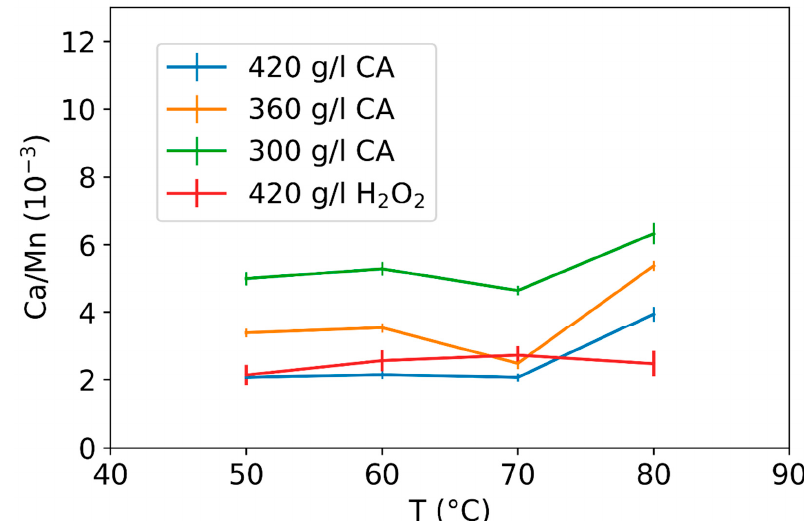
Figure 9. Effect of S/L and temperature on calcium (g/L) to manganese (g/L) ratio after 180 min of reaction time. reaction time.